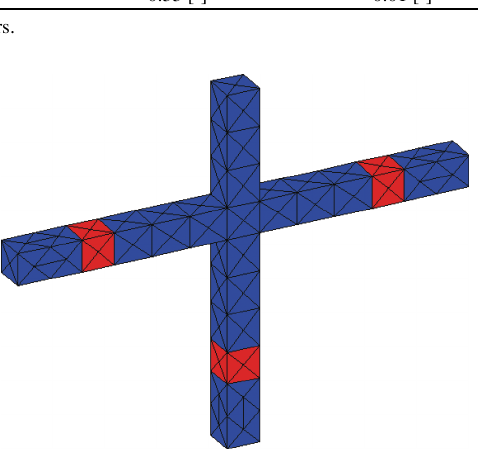
Fig. 4. The mesh used on the test structure in this paper. The soft connectors are indicated with